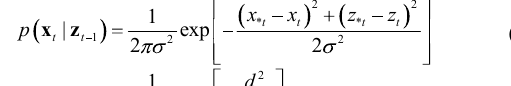
Figure 3. Example of colour and range observations